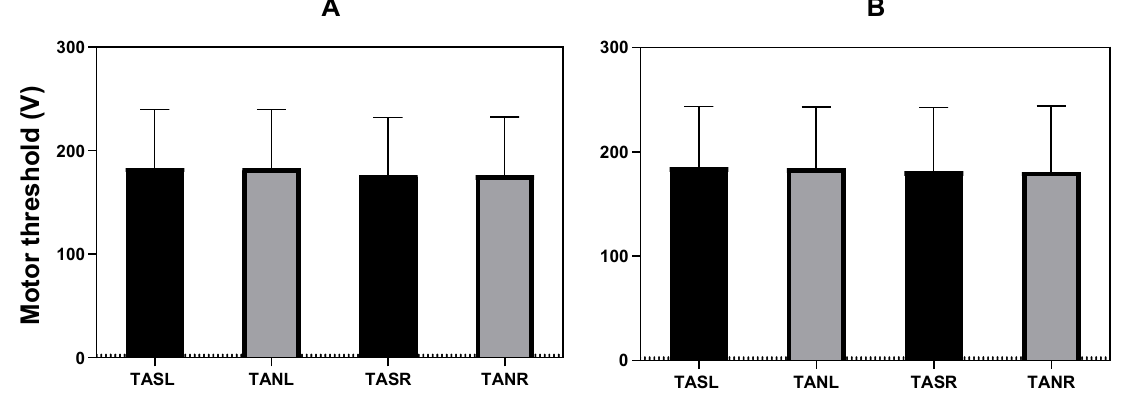
Figure 4. Motor thresholds at the start ( A ) and end ( B ) of surgery. The x -axis denotes the different muscles and recording electrodes used for the mTc-MEP monitoring, and the y-axis denotes the mean motor thresholds in volt. The mean and SD (whiskers) of the motor thresholds for the surface (black bars) and subcutaneous needle electrodes (gray bars) are shown for both the motor thresholds at the start of surgery ( A ) and end of surgery ( B ). Mean motor thresholds were not significantly different between electrode type and side both at the start and end of surgery. TASL, tibialis anterior surface left; TANL, tibialis anterior subcutaneous needle left; TASR, tibialis anterior surface right; TANR, tibialis anterior subcutaneous needle right.